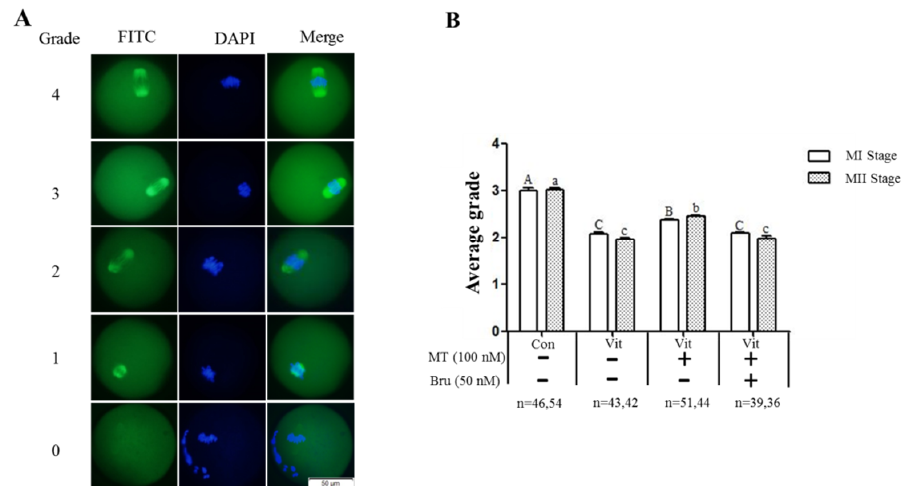
Figure 2. Effects of melatonin (MT) and Brusatol (Bru) on spindle morphology of MI and MII oocytes derived from vitrified-warmed GV oocytes. ( A ): Grades of spindle morphology. ( B ): Average grade of spindle morphology in four groups. Data are presented as mean ± SEM of three independent experiments. Values with different superscripts A (a), B (b), and C (c) differed ( p < 0.05) between groups at the same stages. Scale bar = 50 µm. The four experimental groups: control (Con), vitrifica- tion (Vit), vitrification+ melatonin (Vit + MT), and vitrification + melatonin + Brusatol (Vit + MT